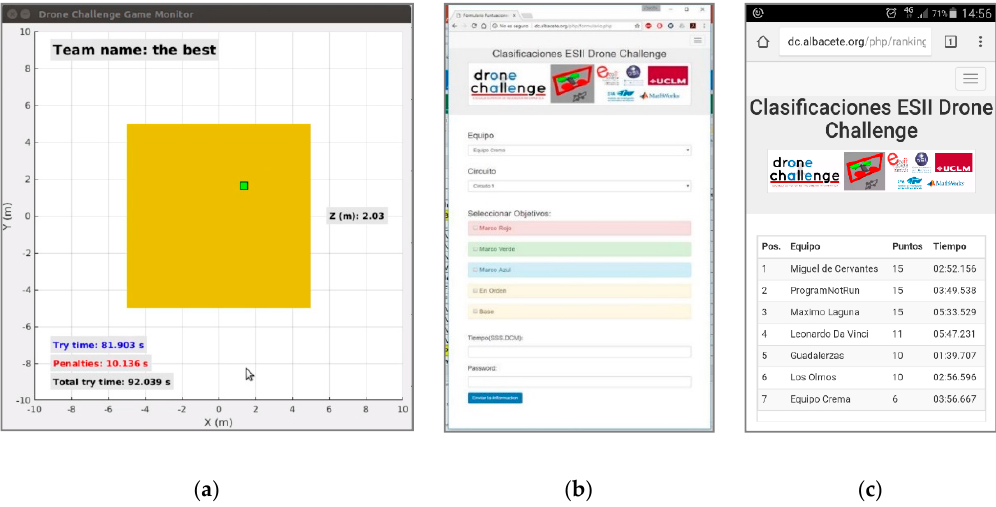
Figure 20. Competition supporting applications: ( a ) scenario top view with statistics; ( b ) judge view; ( c ) ranking view.